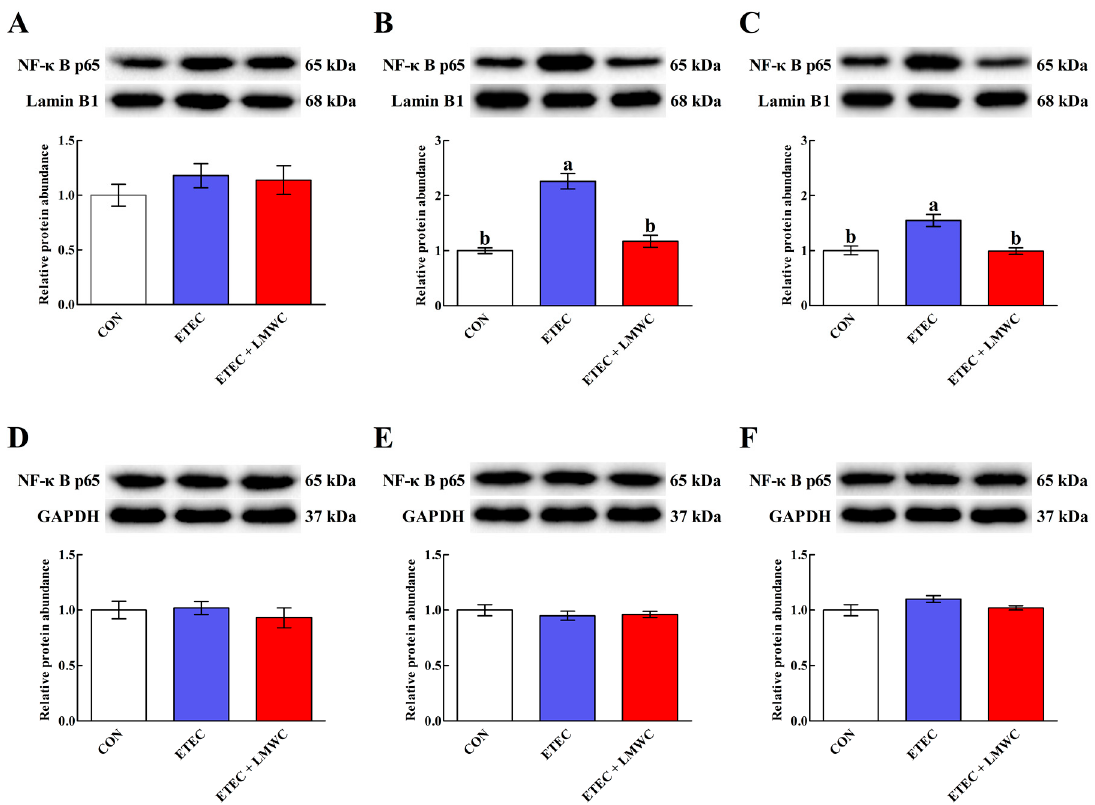
Figure 7. Effects of low-molecular-weight chitosan on the nuclear and cytoplasmic NF- κ B p65 protein abundances in the small intestine of weaned pigs challenged with enterotoxigenic Escherichia coli . ( A – C ) Duodenal, jejunal and ileal nuclear NF- κ B p65 protein abundances, respectively. ( D – F ) Duodenal, jejunal and ileal cytoplasmic NF- κ B p65 protein abundances, respectively. a, b Means with different letters on vertical bars indicate significant differences ( P < 0.05). Values are means ( n = 8 pigs / treatment), with standard errors represented by vertical bars. CON: non-infected control (pigs received the basal diet and infused with sterilised Luria–Bertani culture); ETEC: ETEC-infected control (pigs received the basal diet and infused with enterotoxigenic Escherichia coli ); ETEC + LMWC: pigs received the basal diet supplemented with 100 mg / kg low-molecular-weight chitosan and infused with enterotoxigenic Escherichia coli . NF- κ B p65, nuclear factor- κ B p65. GAPDH, glyceraldehyde-3-phosphate